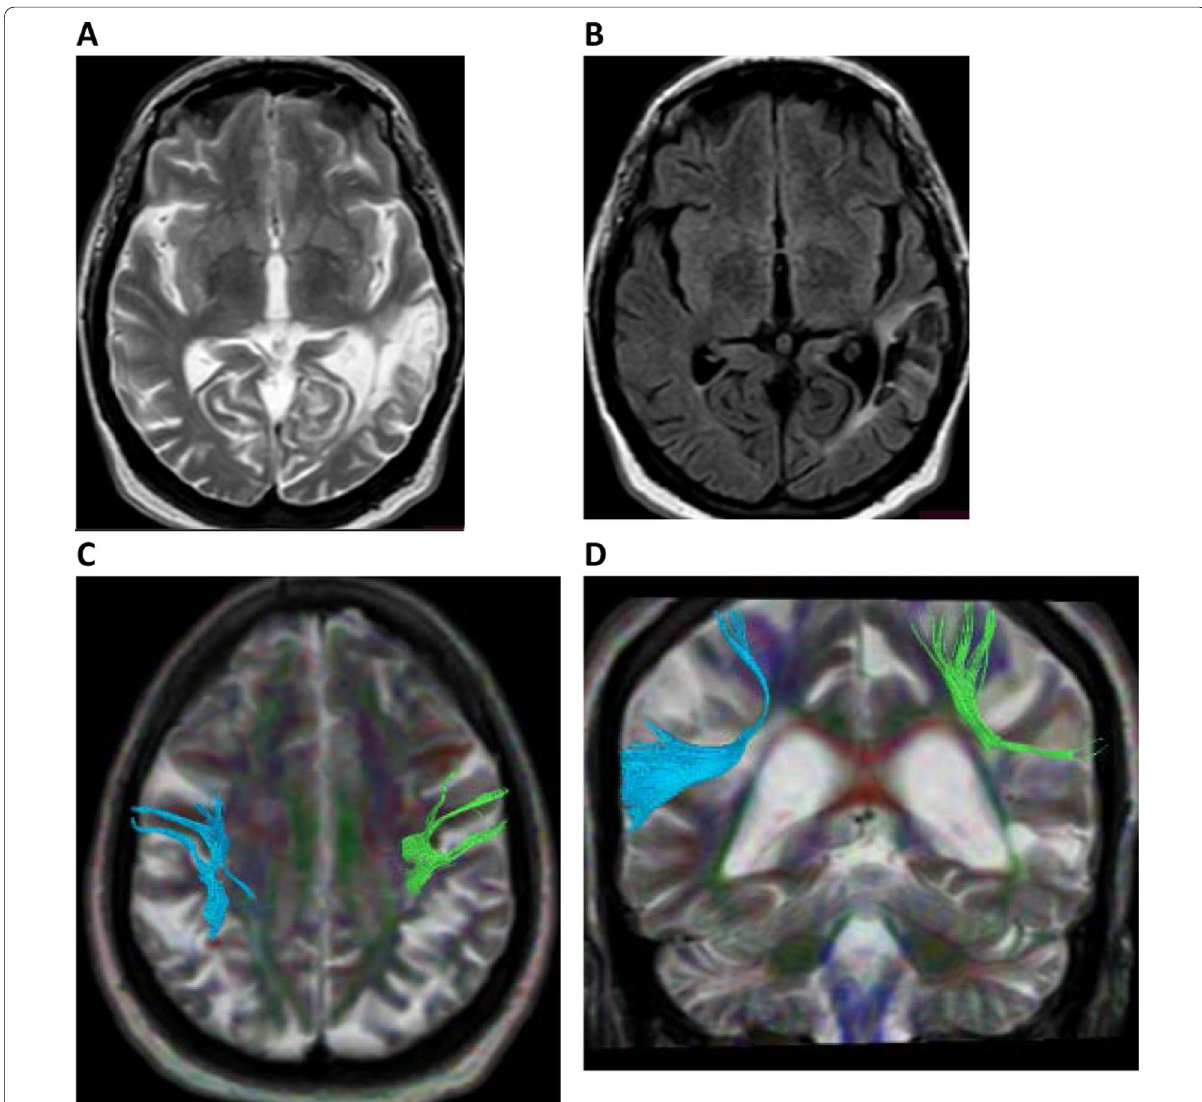
Fig. 3 DTI of patient with sever aphasia 68‑year‑old male, a axial T2‑WI, b axial FLAIR image showing Lt.‑sided infarction, with senile brain atrophic changes, c axial T2 DTI with reconstructed SLF, d coronal T2 DTI image with reconstructed AF showing marked reduction of both AF and SLF size more evident on the Lt. side, with decreased number of fibers, the patient had history of Rt.‑sided infarction 2 years